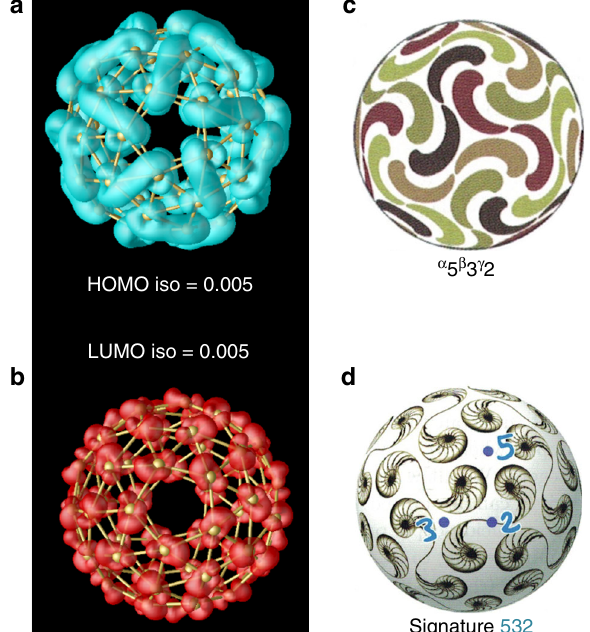
Fig. 4 HOMO and LUMO states of I − Au 60 and chiral-icosahedral symmetry diagrams. At left ( a , b ) are representations of the electron densities of a the fi vefold degenerate occupied (HOMO) states and b the three (3) unoccupied LUMOs, viewed along a C 5 symmetry-axis (Cf. Figure 3a for the energies of these levels.). In particular, the HOMO shows the unique characteristics of the frontier states of the chiral-icosahedral I − Au ‘ bonds ’ that link and cup the 60 cage. In a , one observes 30 ribbon-like Au-sites (These bonds are bisected by the 30 C 2 -axes, are golden in Fig. 1e, bisecting the white rhombi in Fig. 1f, and are 2.74 Å in 1 a .). In b , the densities (60 red cups) indicate non-bonding (or antibonding) character, but these states are unoccupied. To the right are the mathematical representations of chiral-icosahedral ( I ) symmetry, Copyright 2008 From The Symmetries of Things by Conway, Burgiel and Goodman-Strauss.